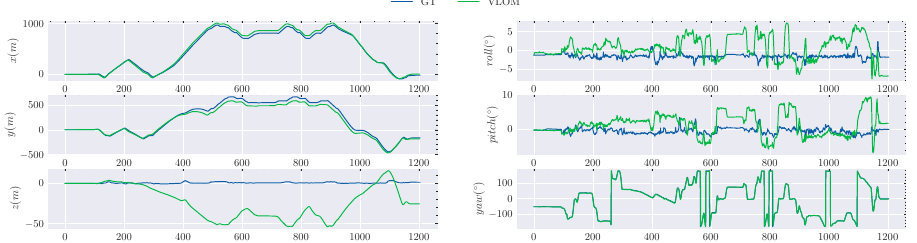
Figure 14. Changes in the position and orientation contrasted with the ground truth on the RS